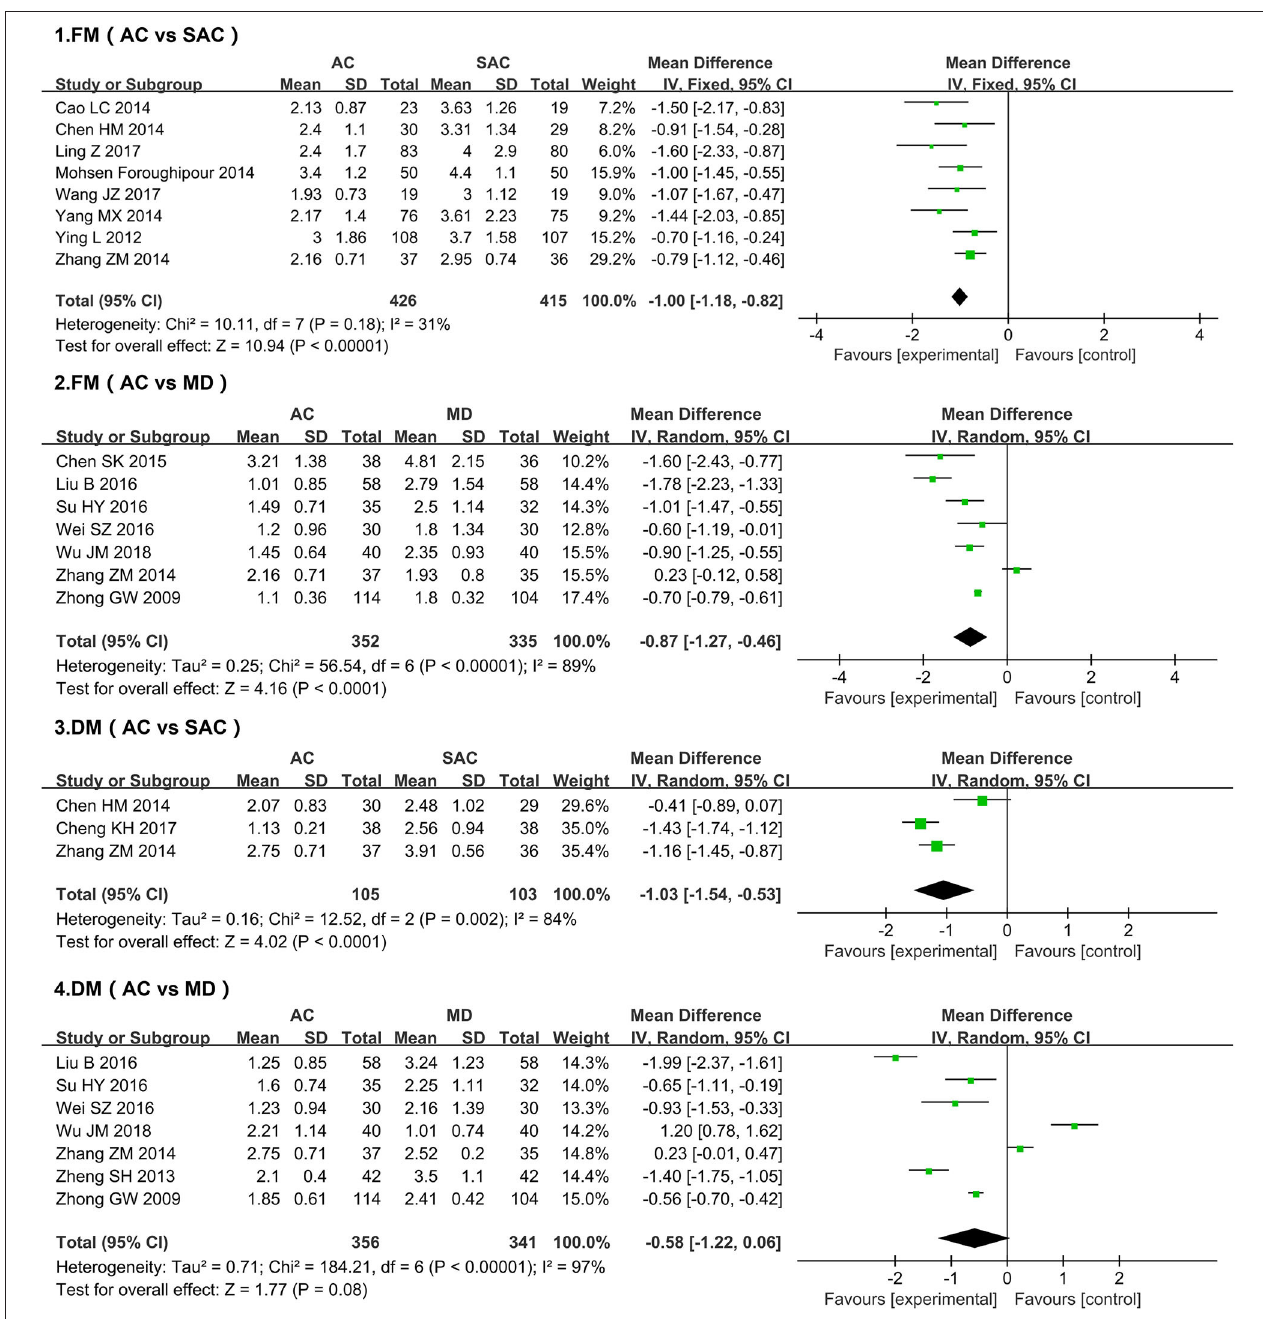
FIGURE 3 | Forest plots of frequency and duration of migraine after acupuncture treatment.